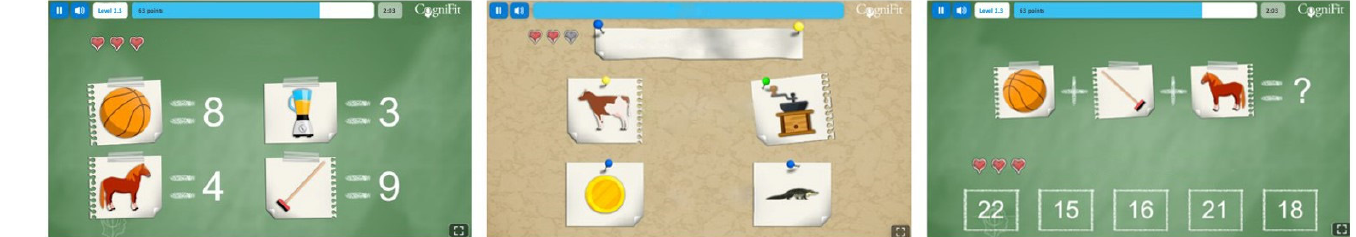
Figure 1. Example of a cognitive stimulation activity. This specific activity is designed to improve attention, working memory, and recognition. The task entails memorizing an image and its associated value ( left picture ); remembering a string of pictures and their locations ( middle picture ); and performing a mathematical calculation based on the values that were initially assigned to each image ( right picture ).